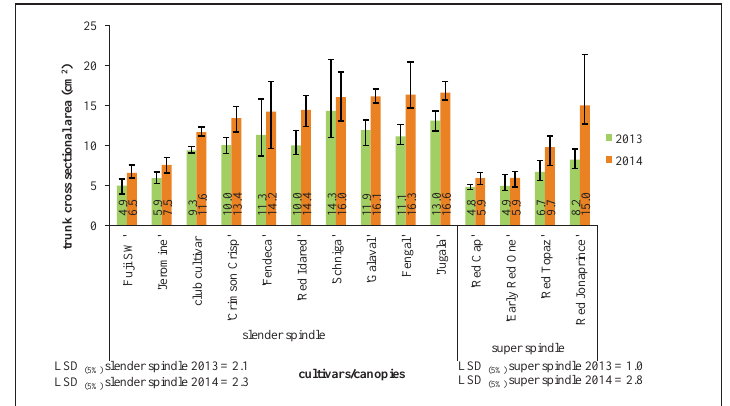
Figure 1: Trunk cross sectional area of the apple cultivars (cm 2 ) (Nyírbátor, 2013 and